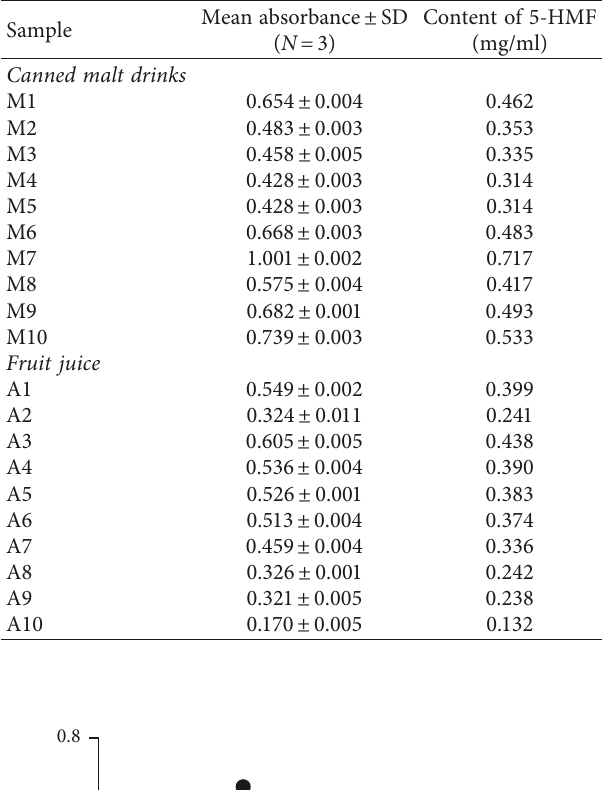
Table 6: Results from the analysis of the samples. Sample